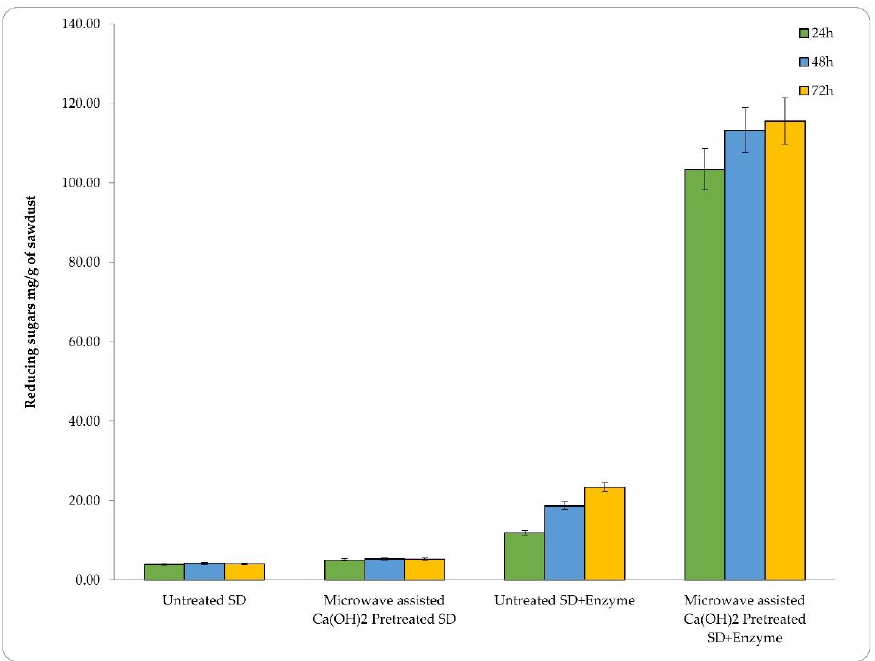
Figure 4. Reducing sugars obtained from untreated and Ca(OH) 2 -pretreated sawdust, with or with- out the fungal crude